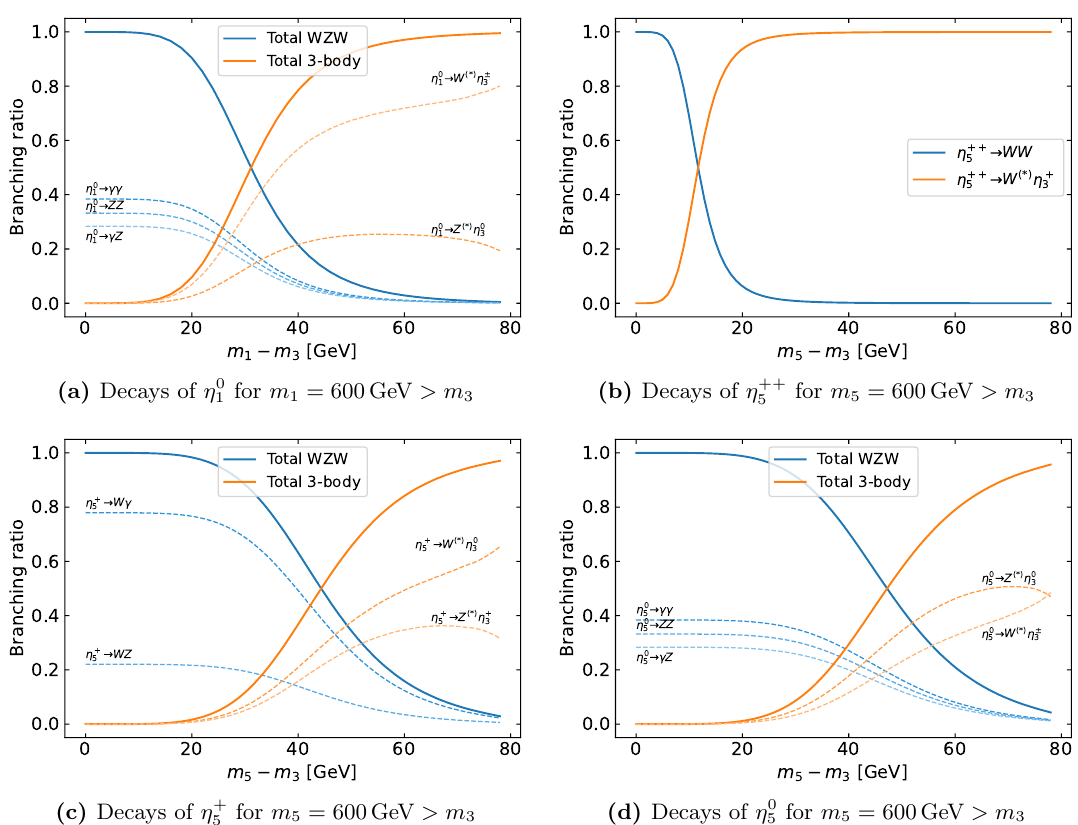
Figure 5. Overview of the pNGB decays in the fermiophobic case. The mass of the decaying particles is set to 600 GeV. The heavier state decays either via the anomaly into di-boson final states or via an (off-shell) gauge boson into a lighter